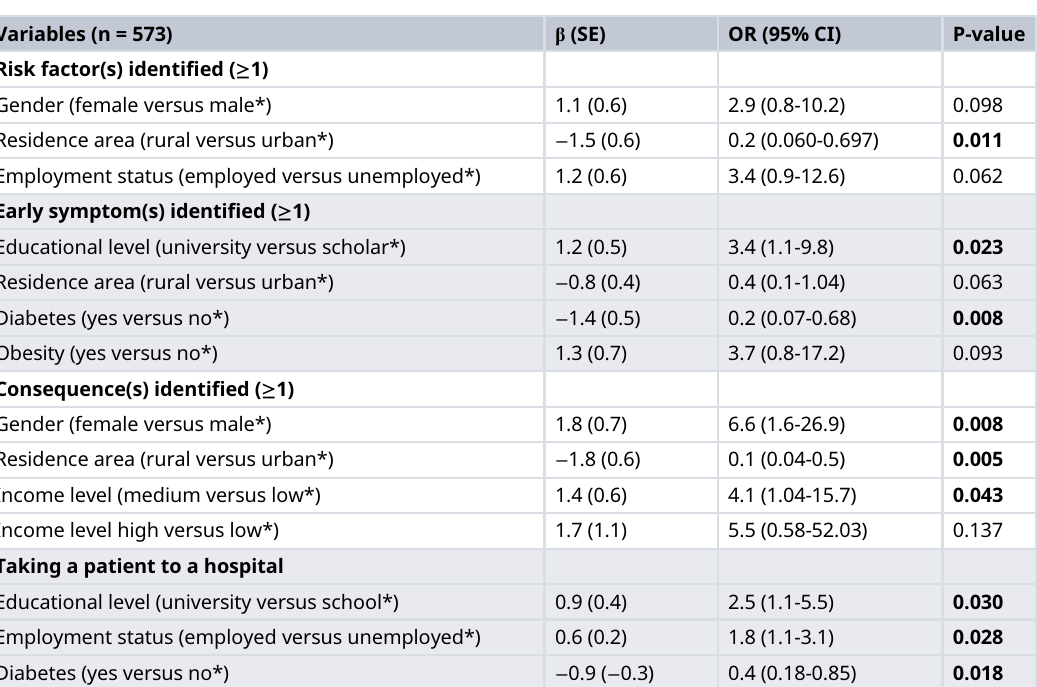
Table 5. Multivariate analysis.